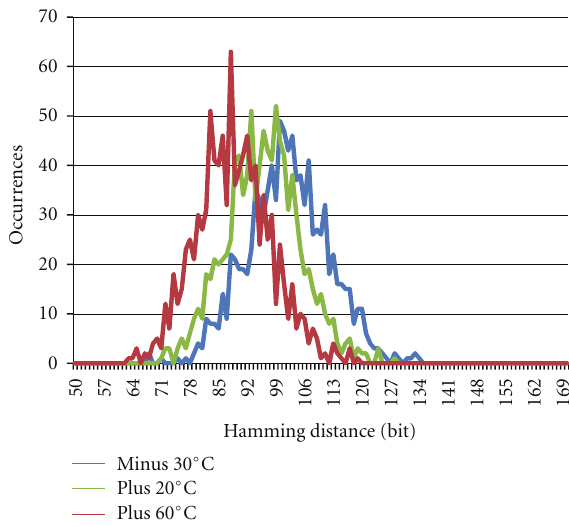
Figure 10: Hamming distance of single readback and master bitstream of board H at di ff erent temperatures.